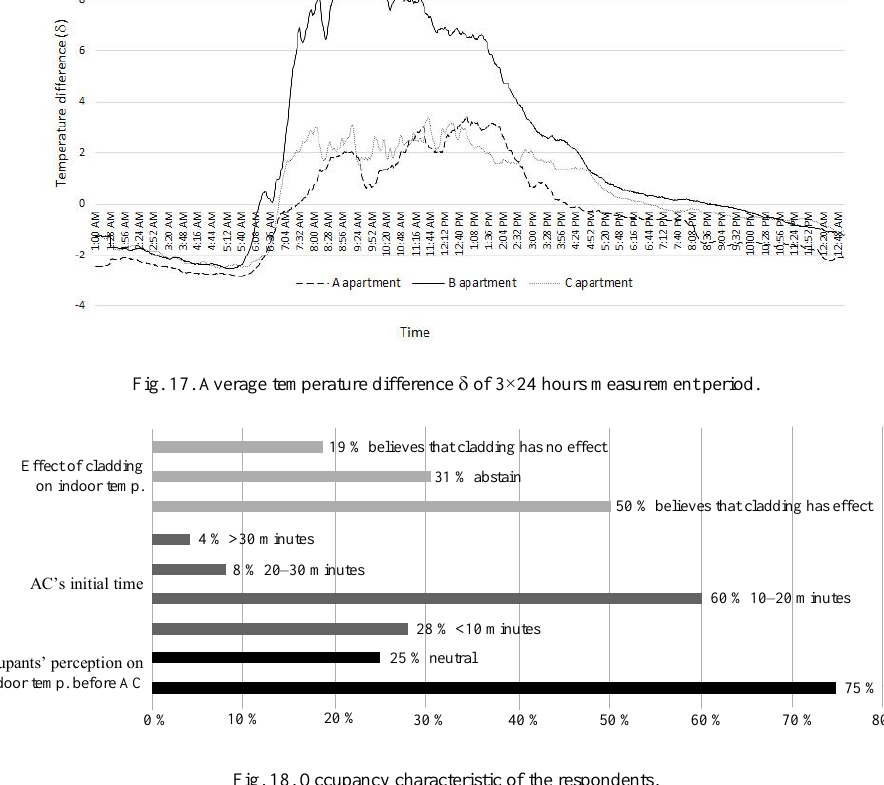
Fig. 18. Occupancy characteristic of the respondents.